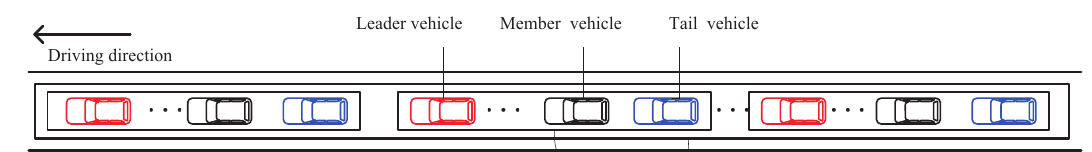
Figure 1. A multi-platoon